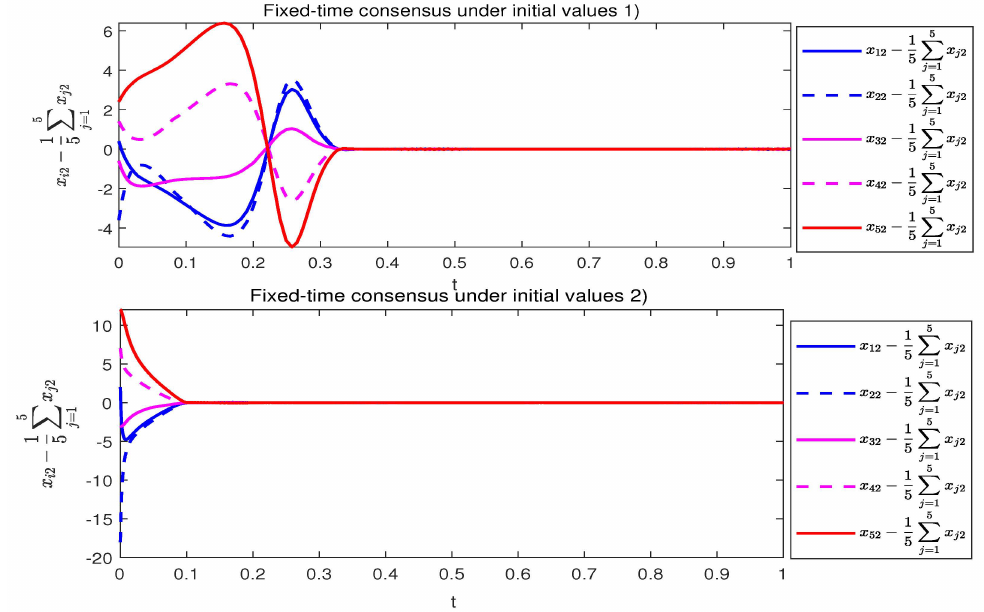
Figure 9. The trajectories of x i 2 for leaderless example under initial values (1) and